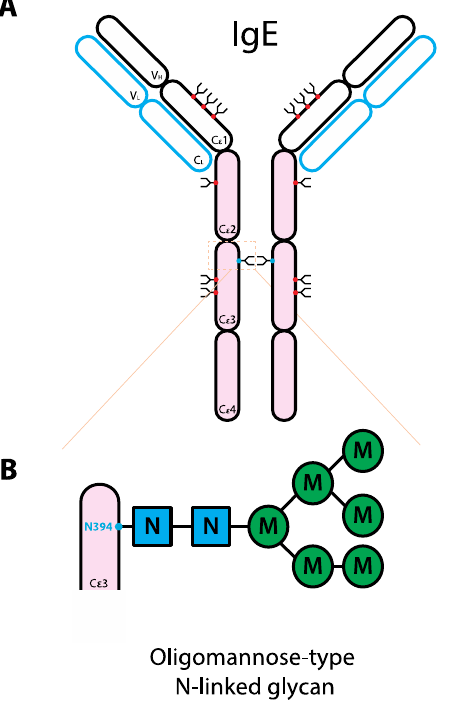
Figure 2. Schematic representation of the human IgE structure and glycan composition. ( A ) IgE structure. IgE protein is comprised of two heavy chains (black outline) and two light chains (blue outline). Each IgE heavy chain has the variable region (V constant region containing four domains (C ε 1-4). Compared to IgG, instead of the hinge region, IgE has an extra domain. Each light chain has variable (V (C ). IgE molecule can be divided into antigen-binding fragment (Fab; empty ovals) and L fragment crystallizable region (Fc; pink ovals). The red and blue dots represent N-linked glycans of complex-type and oligomannose-type, respectively. ( B ) Composition of the oligomannose-type N-linked glycan on IgE N394. The glycan typically consists of 2 GlcNAc with 5 branching mannoses [104], not in order though a range of 4–8 has been reported [33]. Abbreviations: N, GlcNAc; M,